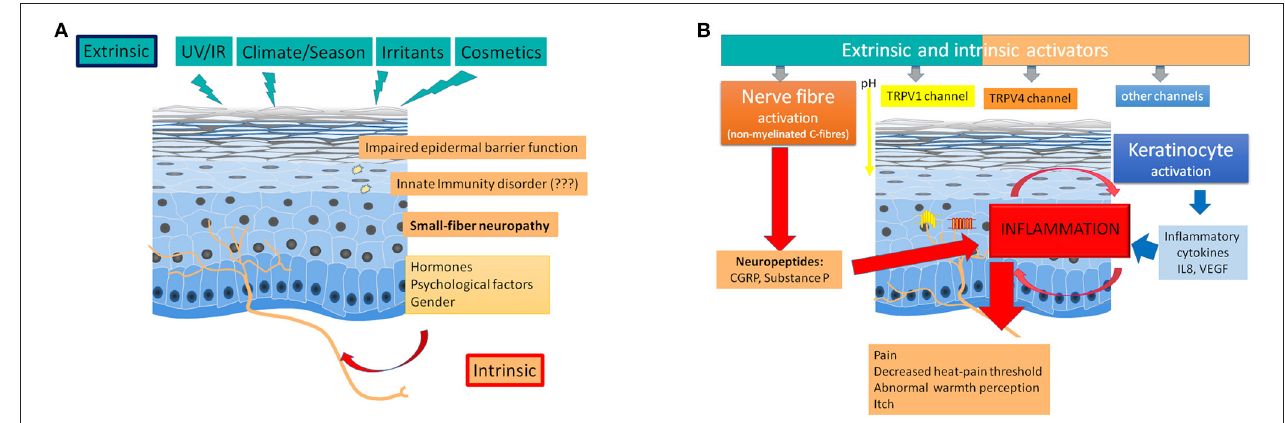
FIGURE 1 | Pathophysiology of sensitive skin. (A) Role of extrinsic and intrinsic factors. Extrinsic factors (like radiations, climate, irritants, or cosmetics) as well as intrinsic factors (like, gender, hormones, or psychological factors) can trigger a small-fiber neuropathy, which is frequently associated with an impaired epidermal barrier function. An innate immunity disorder remains discussed. (B) Induction of inflammation and abnormal perceptions by nerve fiber (and keratinocyte) activation. Extrinsic and intrinsic factors induce an inflammation after an excessive nerve fiber activation (activation of TRPV1, TRPV4, and other channels followed by the release of neuropeptides in the skin) and a keratinocyte activation (inducing the release of cytokines).